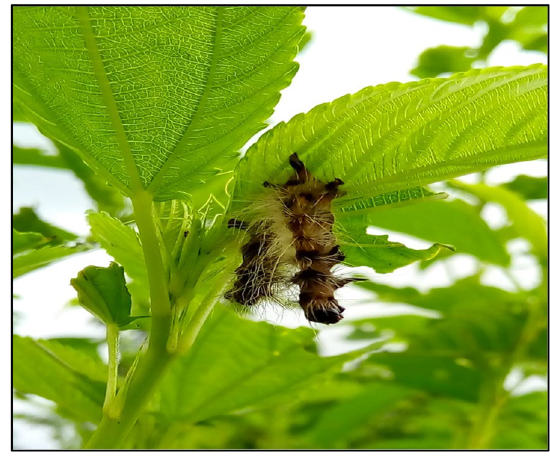
Fig. 1 Larva of Spilosoma obliqua infected with NPV and showing “Wipel Krankheit or Tree Top Disease”